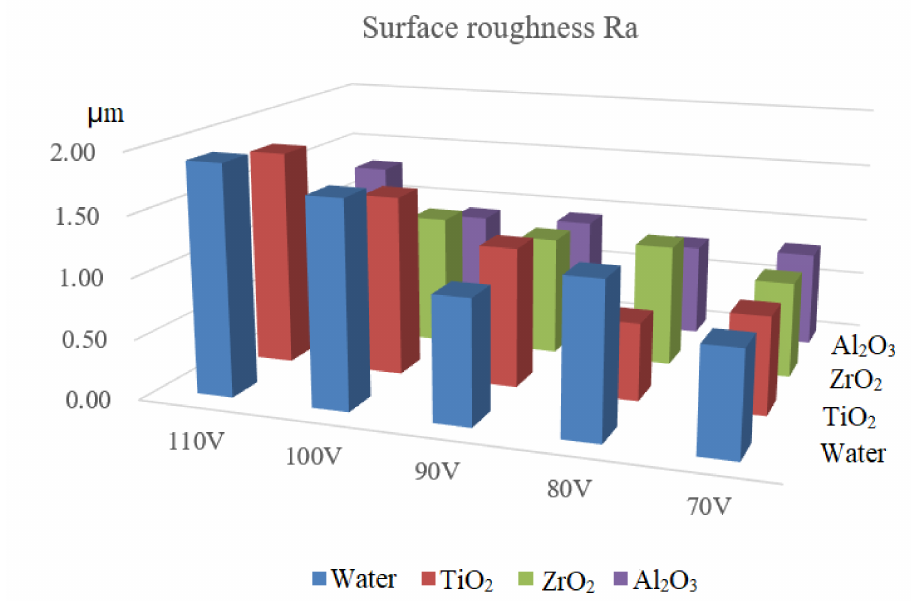
Figure 6. The evolution of surface roughness Ra with the type of nano particle